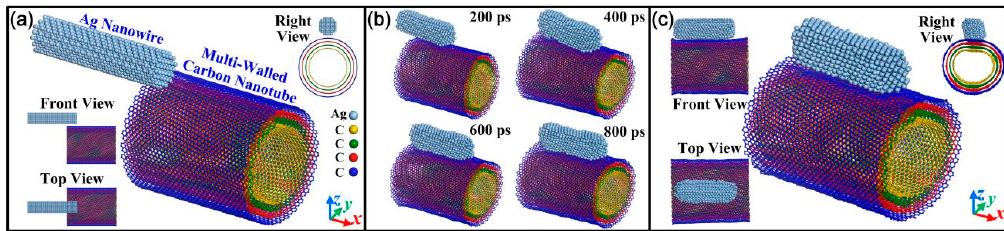
Figure 1. ( a ) Initial atomic configuration of the misaligned structure, ( b ) evolution of configuration, and ( c ) final configuration between the silver nanowire (AgNW) and multi-walled nanotube (MWNT) at 500 K.